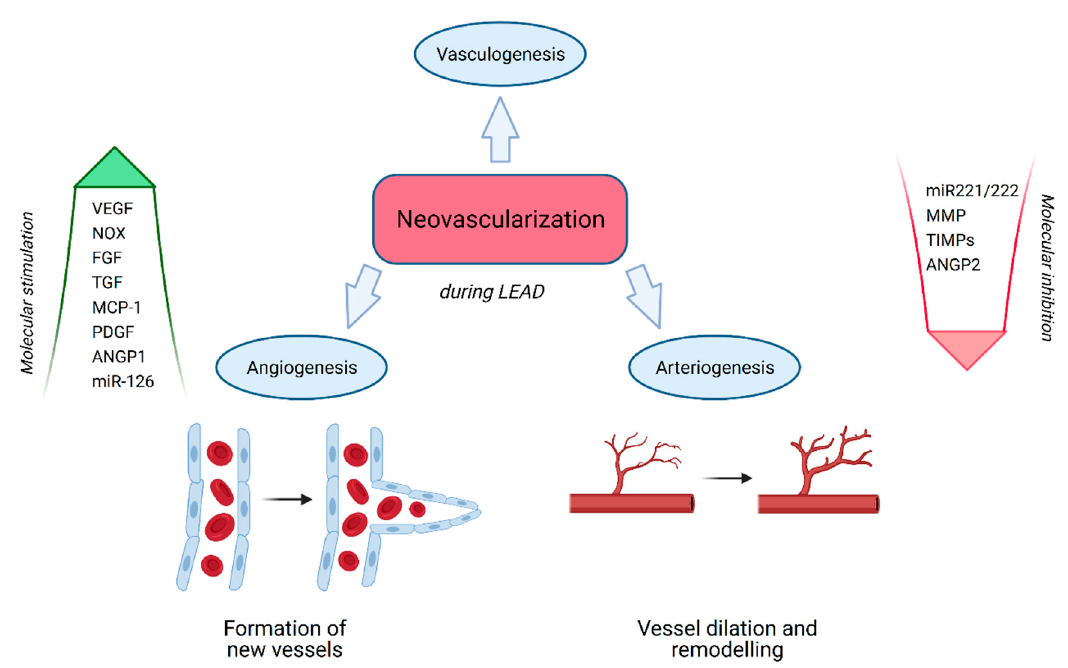
Figure 4. Neovascularization during LEAD. Angiogenesis, described as the process of new capillary formation from pre-existing capillary beds, and arteriogenesis, the process of vessel dilation and remodeling, can be distinguished during LEAD. The most important molecular factors described in this article that can stimulate or inhibit the neovascularization process are presented. Created with